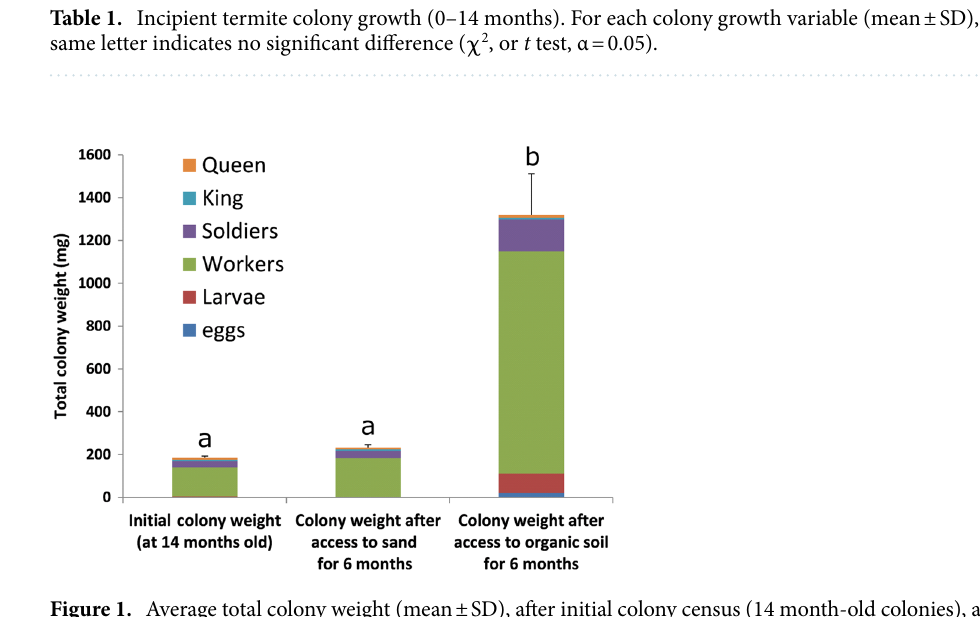
Figure 1. Average total colony weight (mean ± SD), after initial colony census (14 month-old colonies), after exposure to either sand, or organic soil for a period of 6 months (20 month-old colonies). Different letters indicate a significant difference in colony weight (Anova, Tukey post hoc, df = 2, F = 27.6, P <